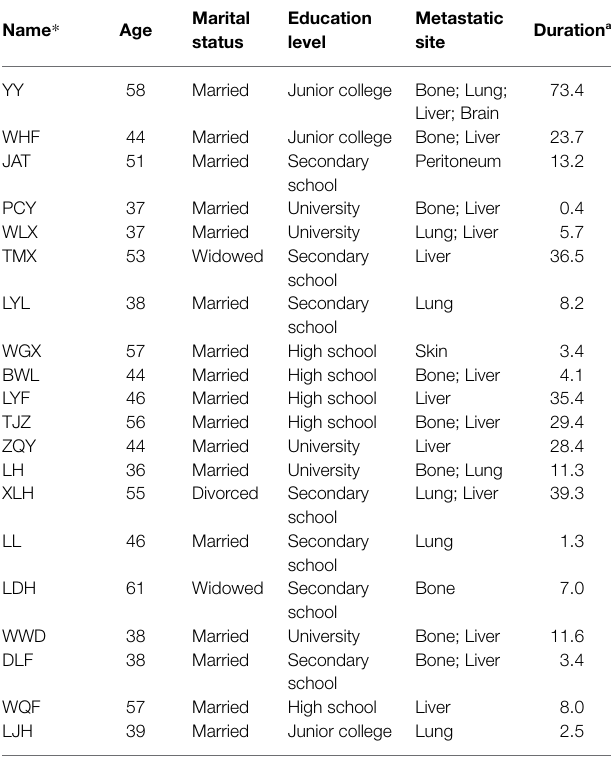
TABLE 1 | Socio-demographic characteristics of MBC women. Name *